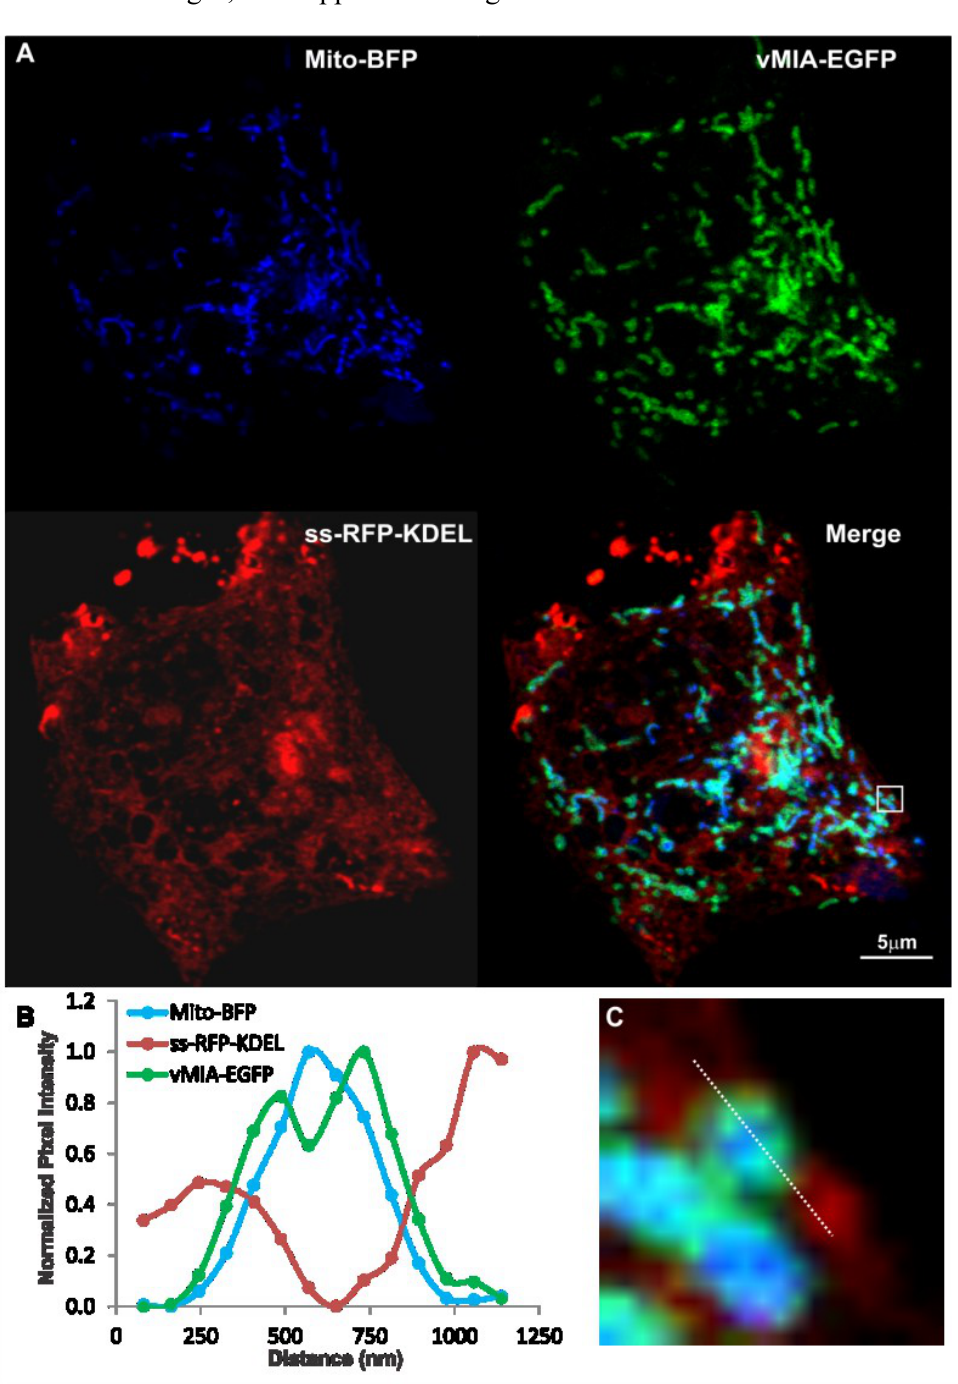
Figure 4. Confocal microscopy imaging of ER-mitochondria interface. HFFs were lipofected with vectors expressing vMIA-EGFP (OMM), ss-RFP-KDEL (ER) and Mito - BFP (matrix) and fixed with 4% PFA at 25 hours after transfection as described below and previously published [23]. ( A ) Cells expressing vMIA-EGFP (green), ss-RFP-KDEL (red) and Mito-BFP (blue) were imaged using confocal microscopy. ( C ) The boxed region of interest from the merged image is enlarged. ( B ) Line scans of vMIA - EGFP (green), ss-RFP-KDEL (red) and Mito-BFP (blue) emissions are shown. For higher resolution images, see Supplemental Figure